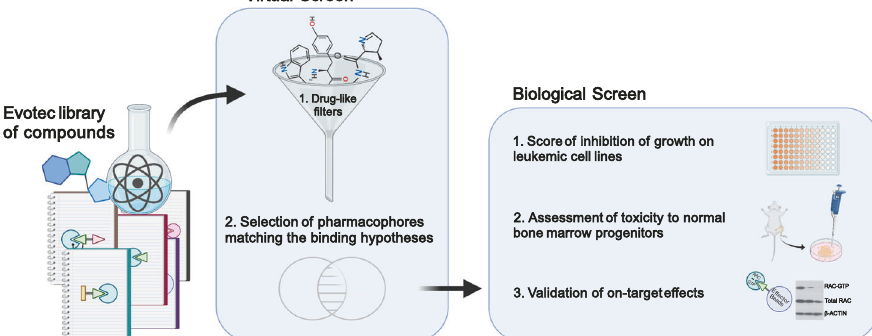
Fig. 1 Compound screen for Rac inhibitors. A virtual screen of Evotec ’ s library of commercially available compounds was performed that included an initial fi ltration for drug-like properties, followed by a preselection against shape-based pharmacophore of published RAC inhibitors. Next, a biological screen was carried out consisting of: (i) scoring for inhibition of growth on leukemic cell lines of 107 selected compounds, (ii) assessment of toxicity to normal bone marrow progenitors of compounds that showed good anti-leukemic activity, and (iii) validating on-target effects by RAC PBD pull down of non-toxic compounds. Created with